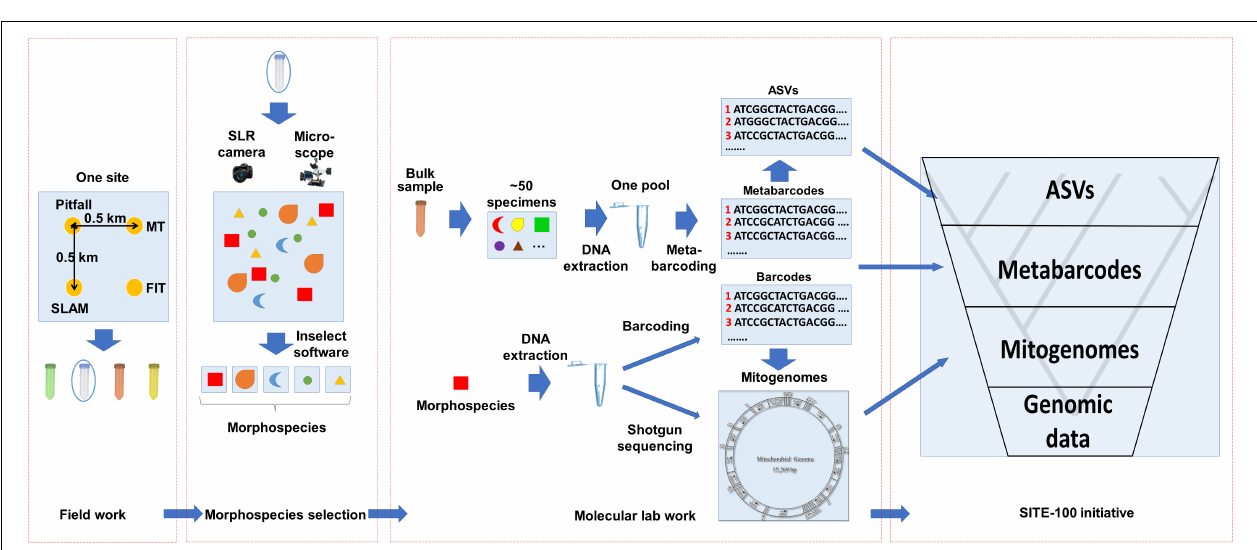
FIGURE 2 | General workflow of the SITE-100 initiative. (1) Field work: Sampling from one site using various standardized collection methods: pitfall trap, Malaise trap (MT), Flight interception trap (FIT) and sea, land, air, and malaise trap (SLAM) to sample from the various strata of a given habitat. (2) Morphospecies selection: Specimens selected in batches of 50 of similar size and digitally imaged with high-resolution imagery. The resulting composite image is separated to morphospecies by employing open-source software Inselect (Hudson et al., 2015). (3) Molecular lab work: A hybrid approach of cox1 metabarcoding of bulk samples and mitochondrial metagenomics of individual specimens representing unique morphospecies. For the latter, cox1 barcodes are produced in parallel as baits for recovery of mitogenomes from mixed sequencing libraries. (4) SITE-100 database and analyses: Phylogeny reconstruction of hierarchical datasets and metabarcode placement for Tree-of-Life construction and biodiversity